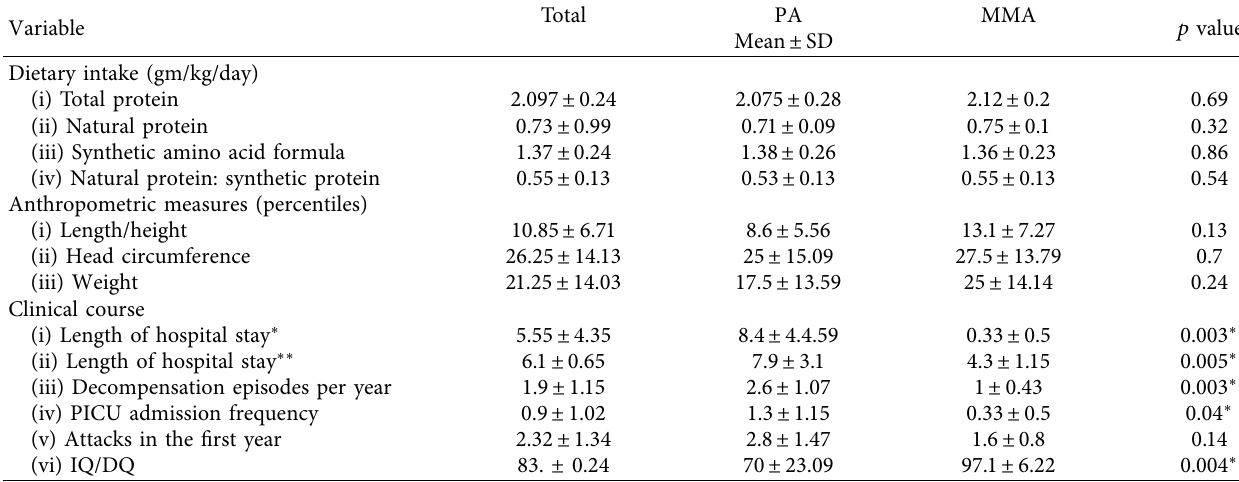
Table 7: Comparison between PA and MMA